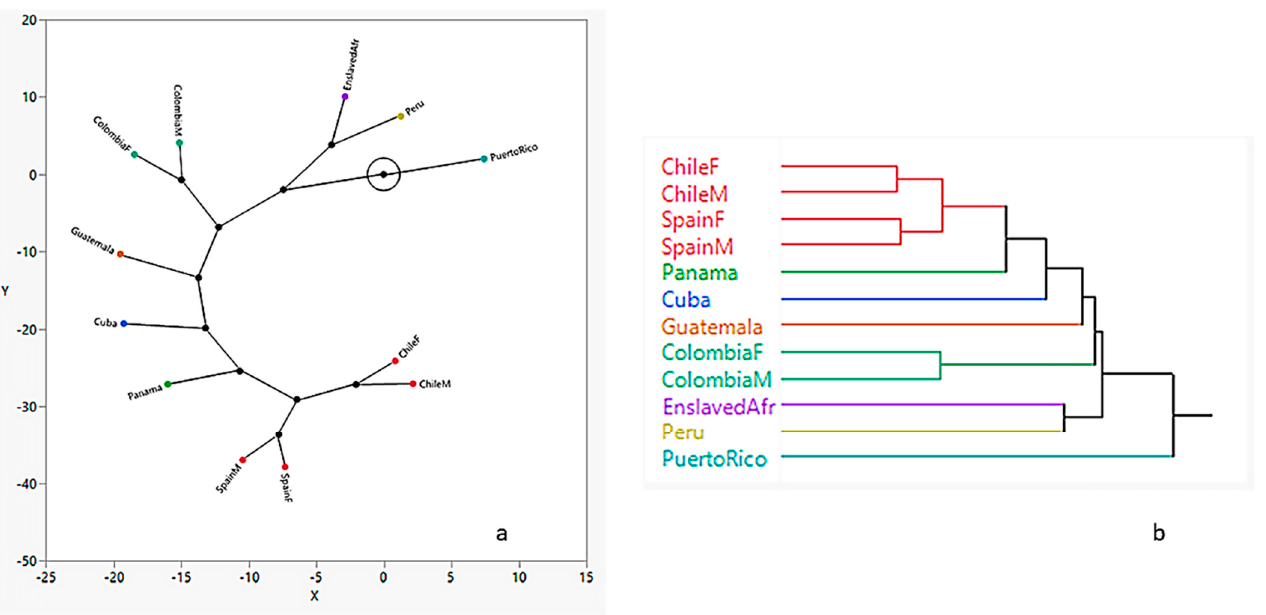
Figure 4. Constellation plot ( a ) and dendrogram ( b ) results from hierarchical cluster analysis showing group relationships.